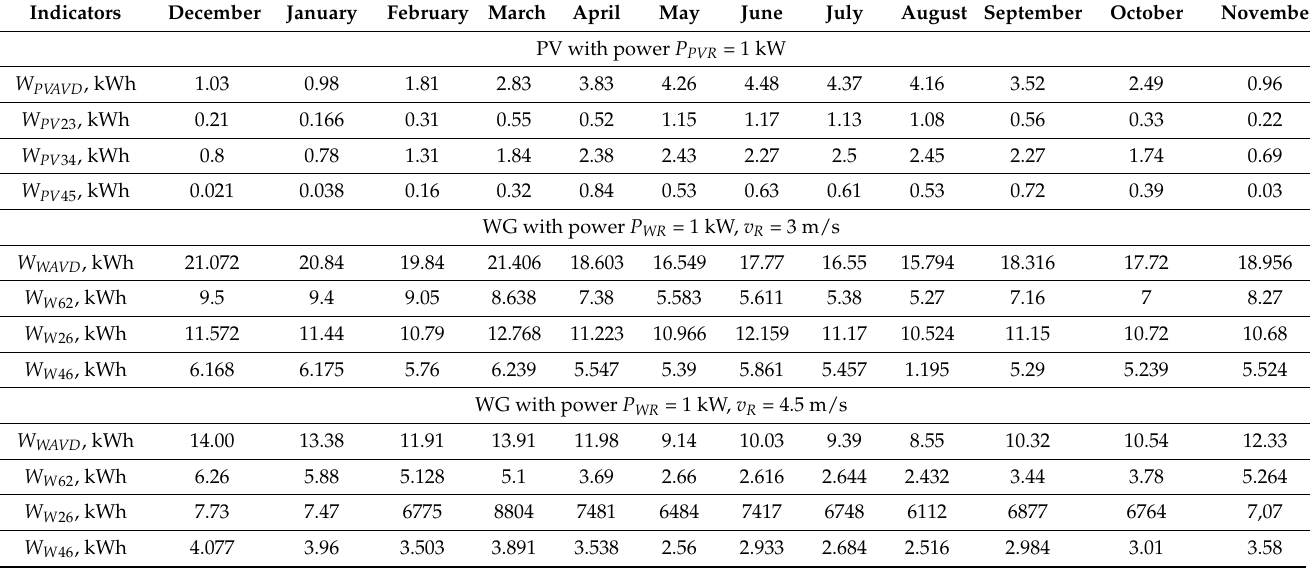
Table 1. Indicators of average PV and WG energy